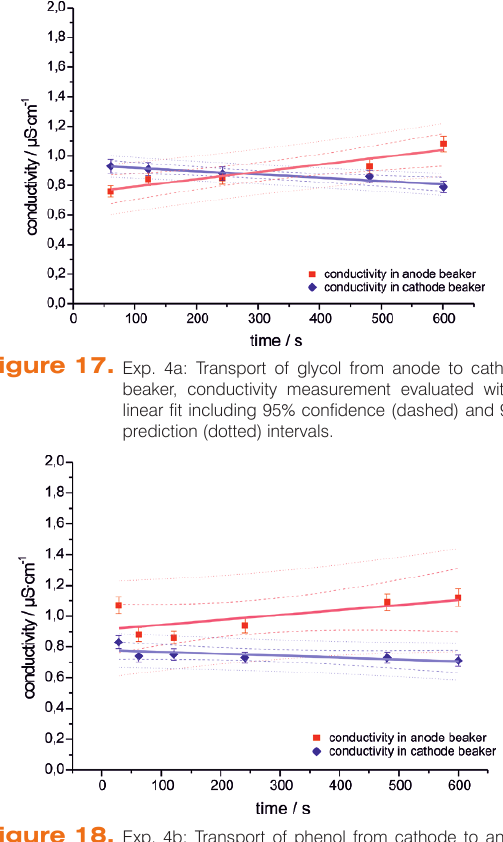
Figure 18. Exp. 4b: Transport of phenol from cathode to anode beaker, conductivity measurement. The values are evaluated with a linear fit including 95% confidence (dashed) and 95% prediction (dotted) intervals.